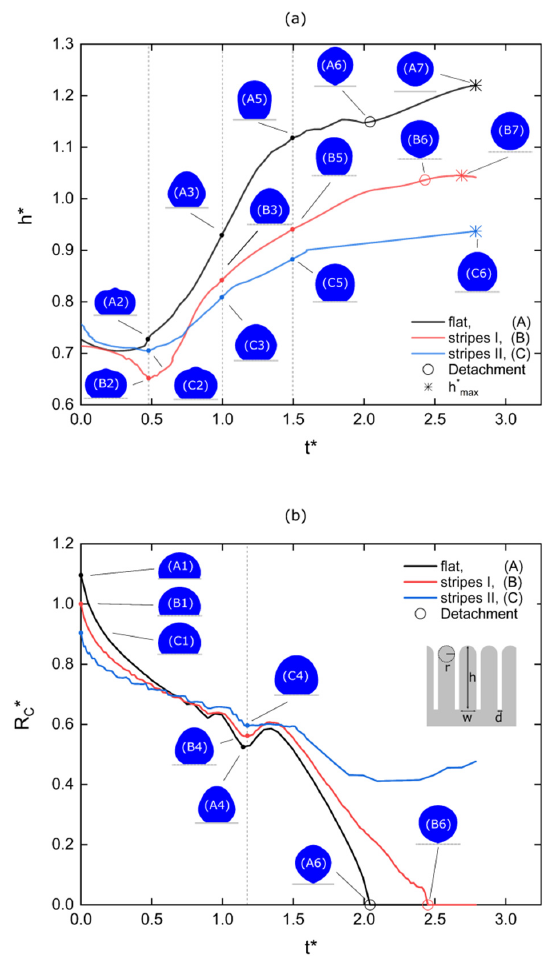
Figure 6. ( a ) time evolution of the normalized height (center of mass) for the case of the flat surface (black line, (A)), surface with axisymmetric stripes of h = 85 µ m, w = 15 µ m, d = 3 µ m and r = 5 µ m (red line, (B)) and surface with axisymmetric stripes of h = 75 µ m, w = 20 µ m, d = 5 µ m and r = 10 µ m (blue line, (C)). States (A6) and (B6) corresponds to detachment and (A7), (B7), (C6) to acquisition of maximum height. ( b ) time evolution of the normalized contact radius for the same cases as (a). States (A1), (B1), (C1) corresponds to initial contact radius before changing the wettability. For the perfectly smooth substrate the time of detachment is approximately 2 t c and for the first structured substrate is approximately 2.5 t c .